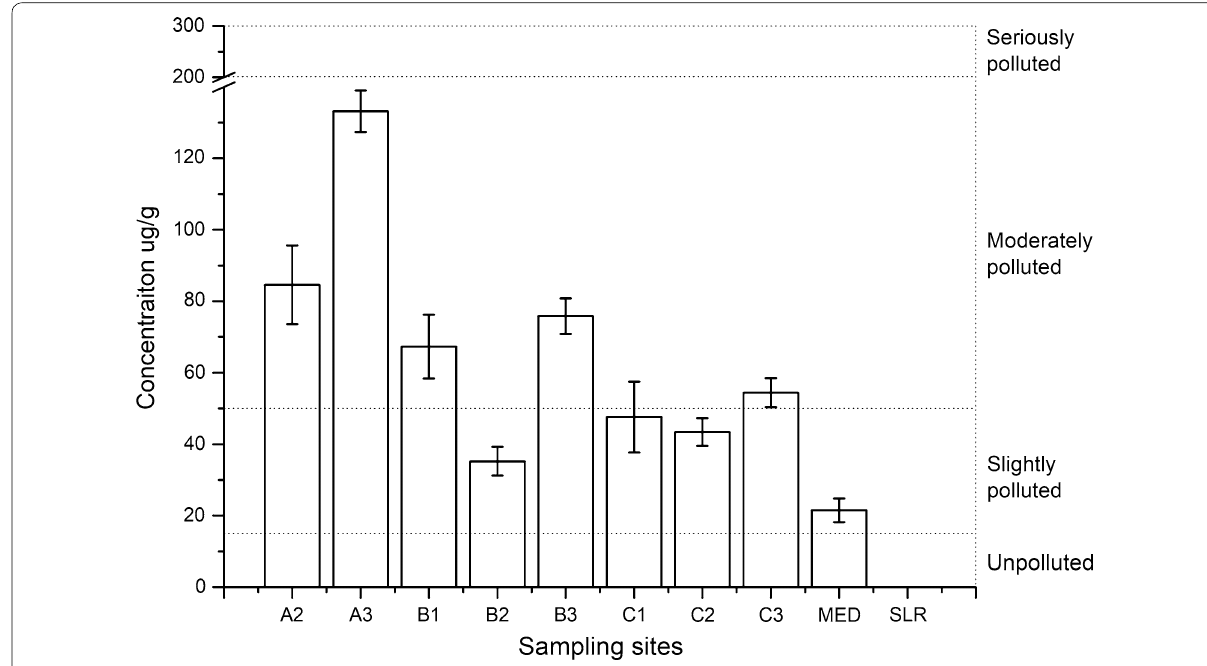
Fig. 2 The total petroleum hydrocarbons in sampling sediment analysis by fluorescence spectrophotometry. The concentrations of the TPHs were calculated by the standard curve. The site A3 was next to the leak point. No TPH was detected at site SLR. The symbol An (Bn, Cn): the nst sampling site of line A (B, C); MED: control site in Jiaozhou Bay; SLR: control site in Shilaoren Beach, which was outside of Jiaozhou Bay